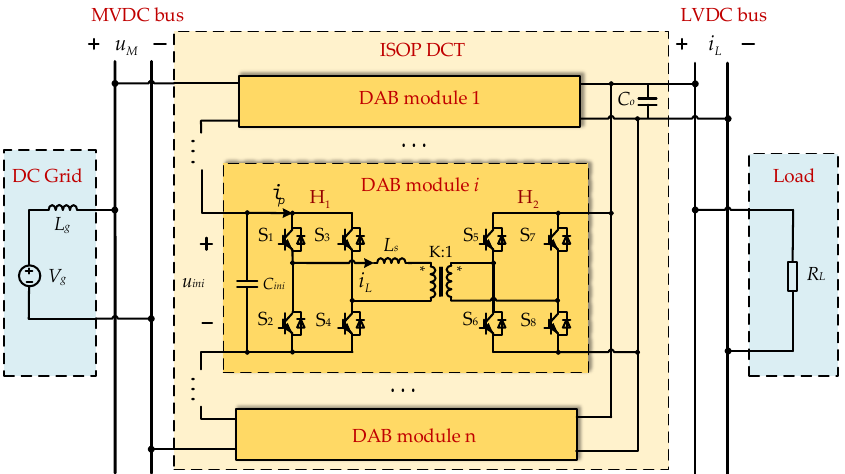
Figure 2. Structure of the MVDC distribution system. R L is the load impedance. u M and u L are the MVDC and the LVDC bus voltage, respectively. Meanwhile, u L is the voltage of the output capacitance C o . In the DC grid, V g is the DC grid voltage, L g is the transmission line inductance. In the ISOP DCT, C o is